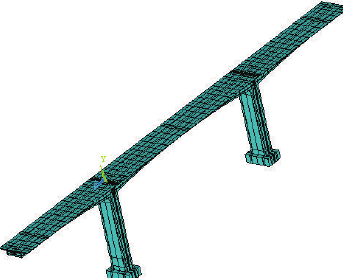
Figure 7: Finite element model of the continuous rigid-frame bridge.